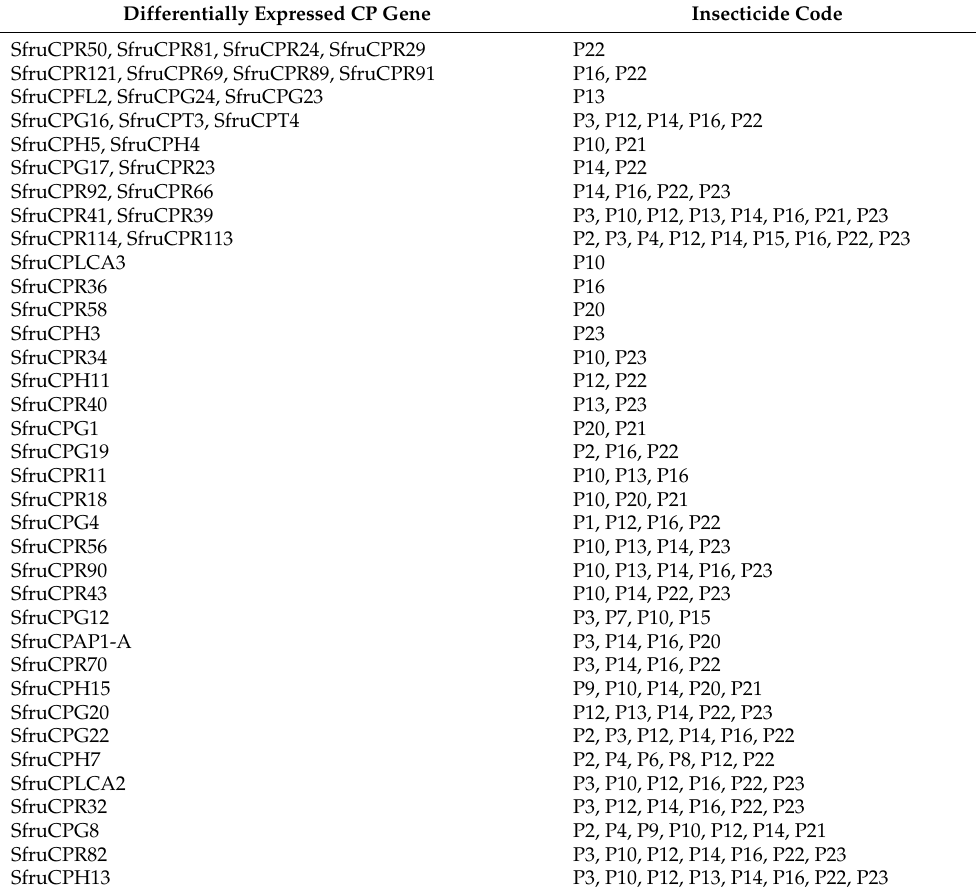
Figure 4. Relative expression level of eight candidate CP genes after exposure to four different insecticides. The expression of CPs was analyzed by RT-PCR. The actin gene was used as an internal reference. The detailed information of four different insecticides corresponding to their codes (P10, P14, P16 and P23) are represented in Table 2. The 3rd instar larvae of FAW exposed to different insecticides after 24 h and 48 h were used for RT-PCR analysis. CK represents no treatment of insecticides. It should be noted that if the expression of selected eight candidate CP genes do not change after exposure to these insecticides through RNA-seg analysis, their expressions are not further validated by RT-PCR analysis. Thus, the missing data for some treatments at each timepoint (24 h or 48 h after treatment) indicate that the CP gene expression was not validated by RT-PCR analysis. Table 3. Detailed list of differentially expressed CP genes after exposure to different